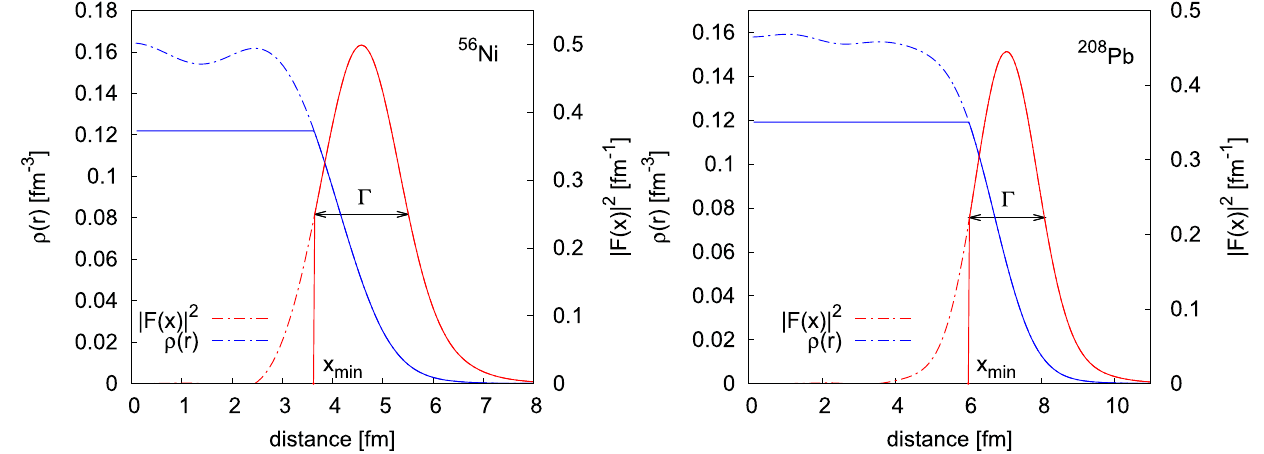
Figure 1. The densities ρ ( r ) (in fm − 3 ) of 56 Ni and 208 Pb calculated in the Skyrme HF + BCS method with SLy4 force (normalized to A = 56 and A = 208, respectively) and the weight function | F ( x ) | 2 (in fm − 1 ) normalized to unity (Equation (13)).